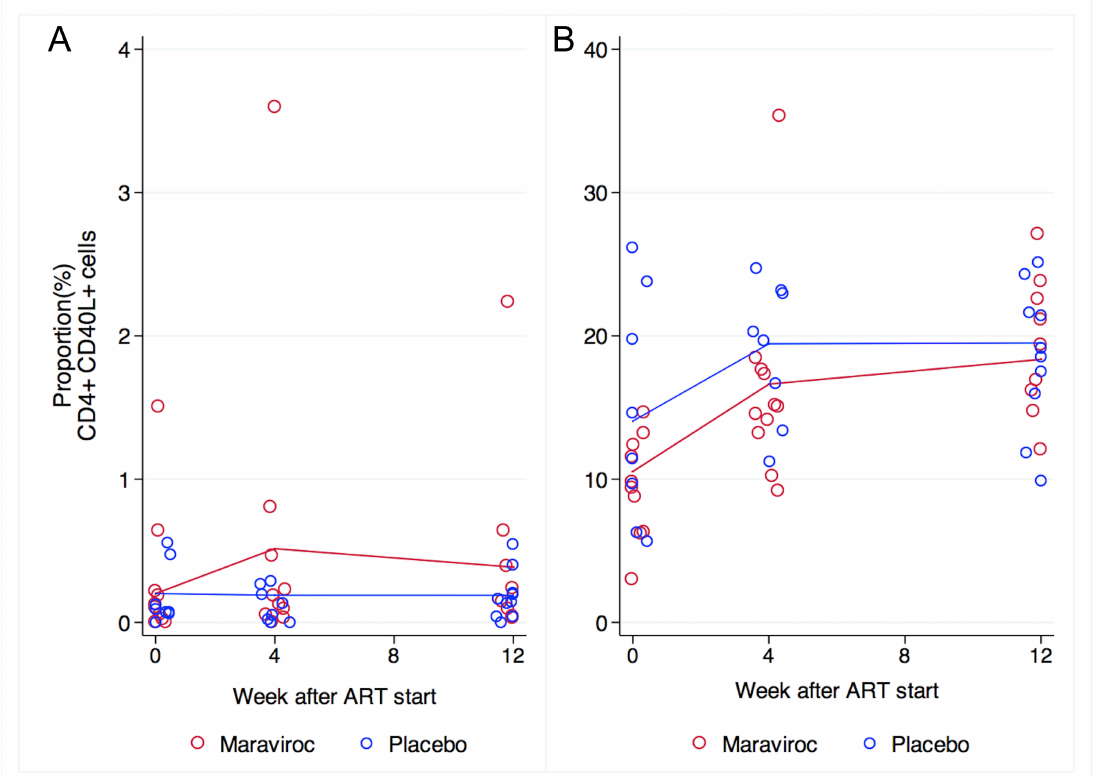
Supplementary Figure 3. Proportion of CD4 lymphocytes expressing CD40L upon exposure to CMV peptides and